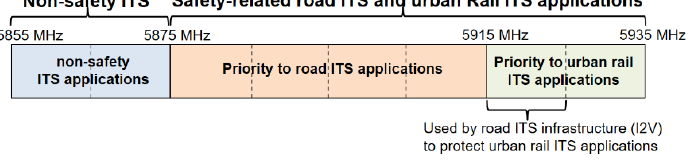
Figure 14. Frequency band for ITS